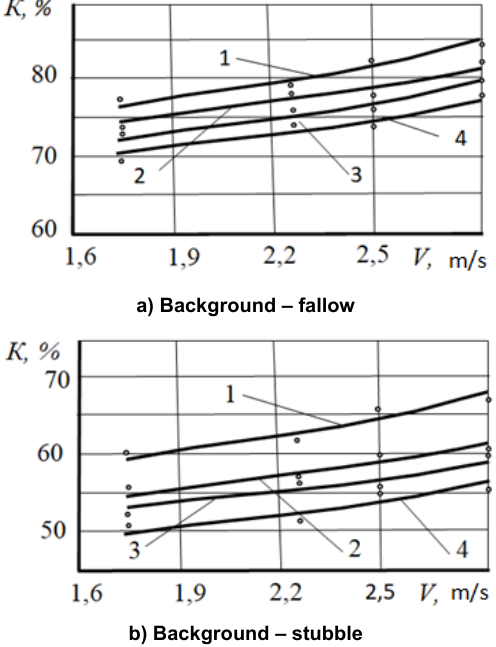
Figure 5 - The influence of the speed of movement of the unit and the technological scheme of the tool on the crumbling of the soil (fractions: up to 25 mm - fallow; up to 50 mm - stubble)